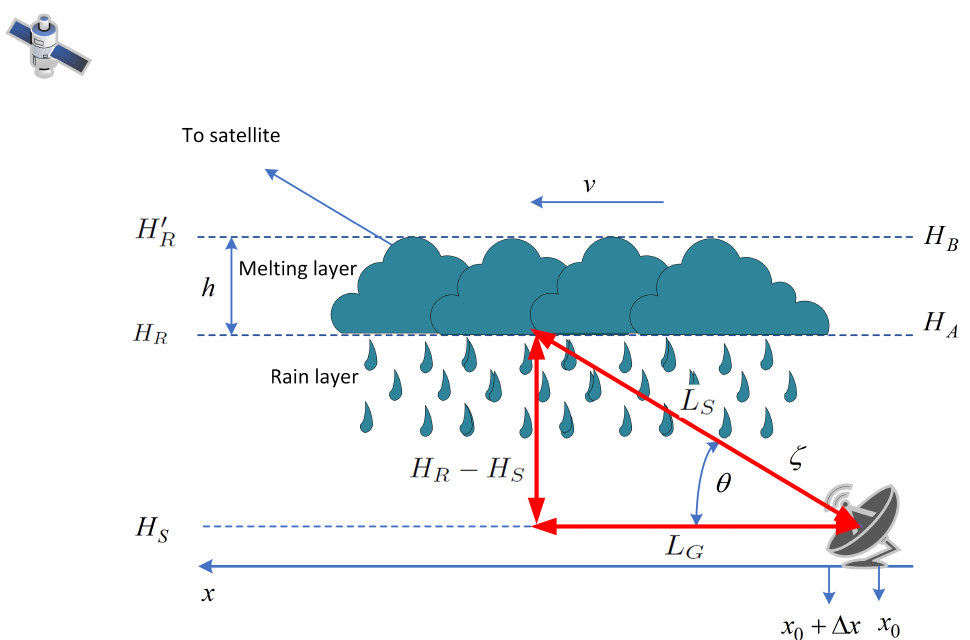
Figure 2. Illustration of two-layer structured rain attenuation model for the slant